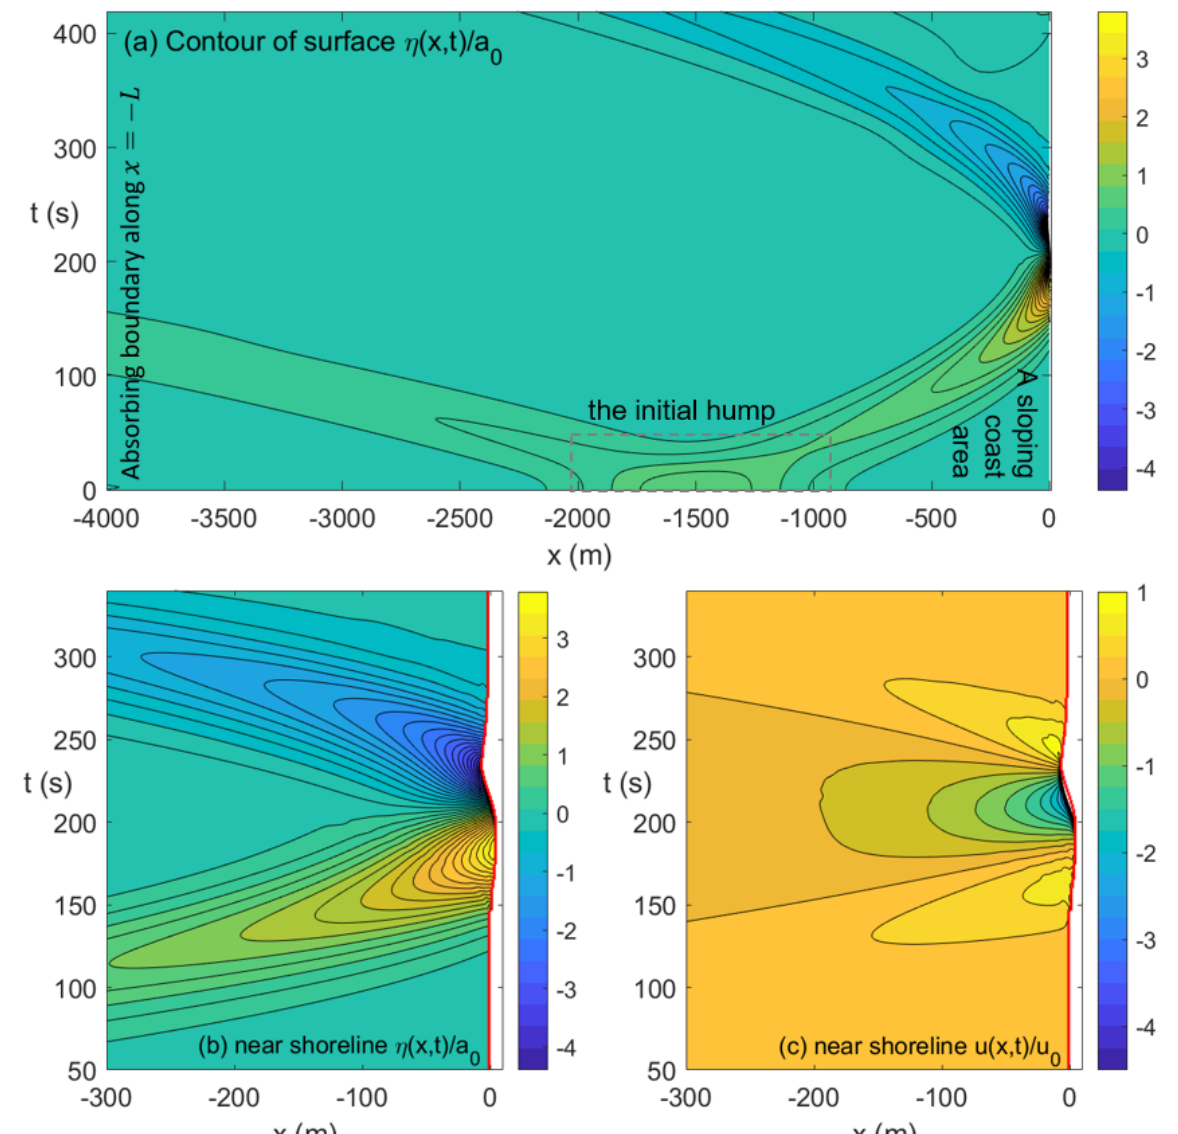
Figure 3. ( a ) Contour plot of the normalized numerical surface η ( x , t ) / a 0 ; ( b ) the enlarged contour plot of η ( x , t ) / a 0 near the shoreline; and ( c ) the corresponding contour plot of u ( x , t ) / u 0 near the shoreline, where the red curves represent the